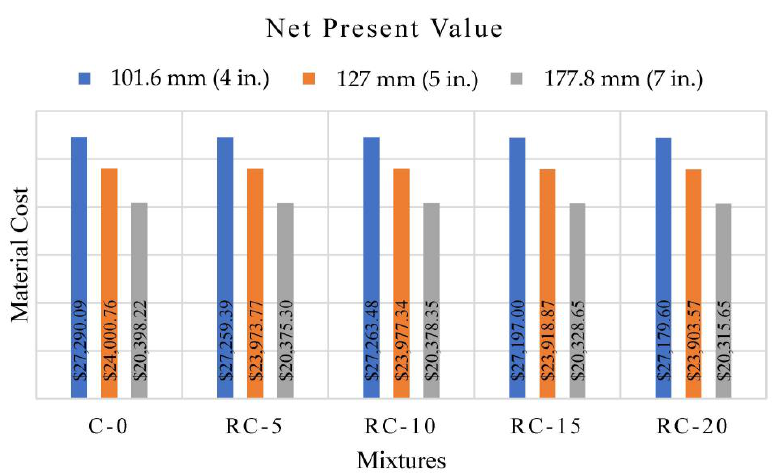
Figure 28. Net present values of implementing different concrete mixtures for TWT at the intersec- tion.